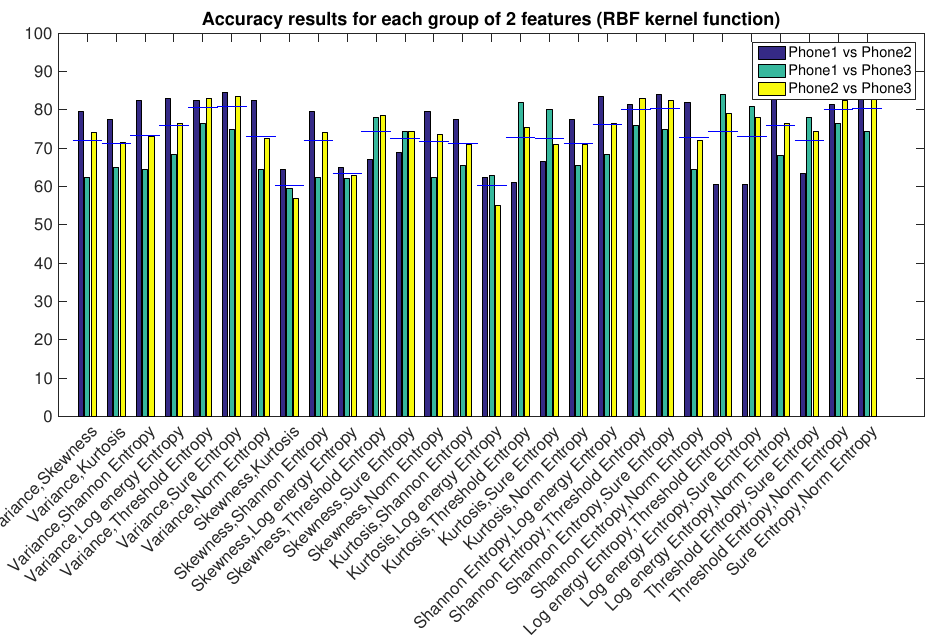
Figure 7. Features combination in groups of two for indirect comparisons. Best group: Variance, Sure Entropy , Average accuracy of